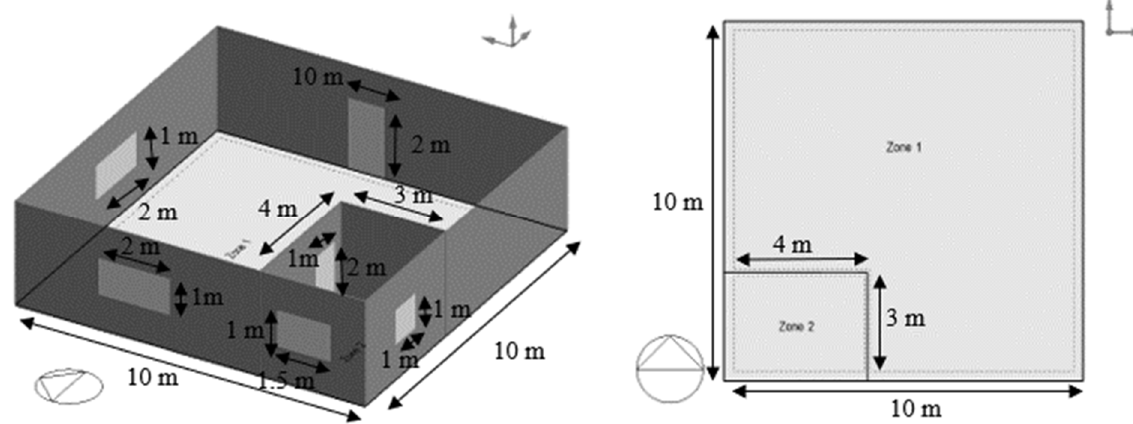
Figure 1. The 3-D model and plan for the generic building. Table 2. Design specification and assumptions of the generic building.